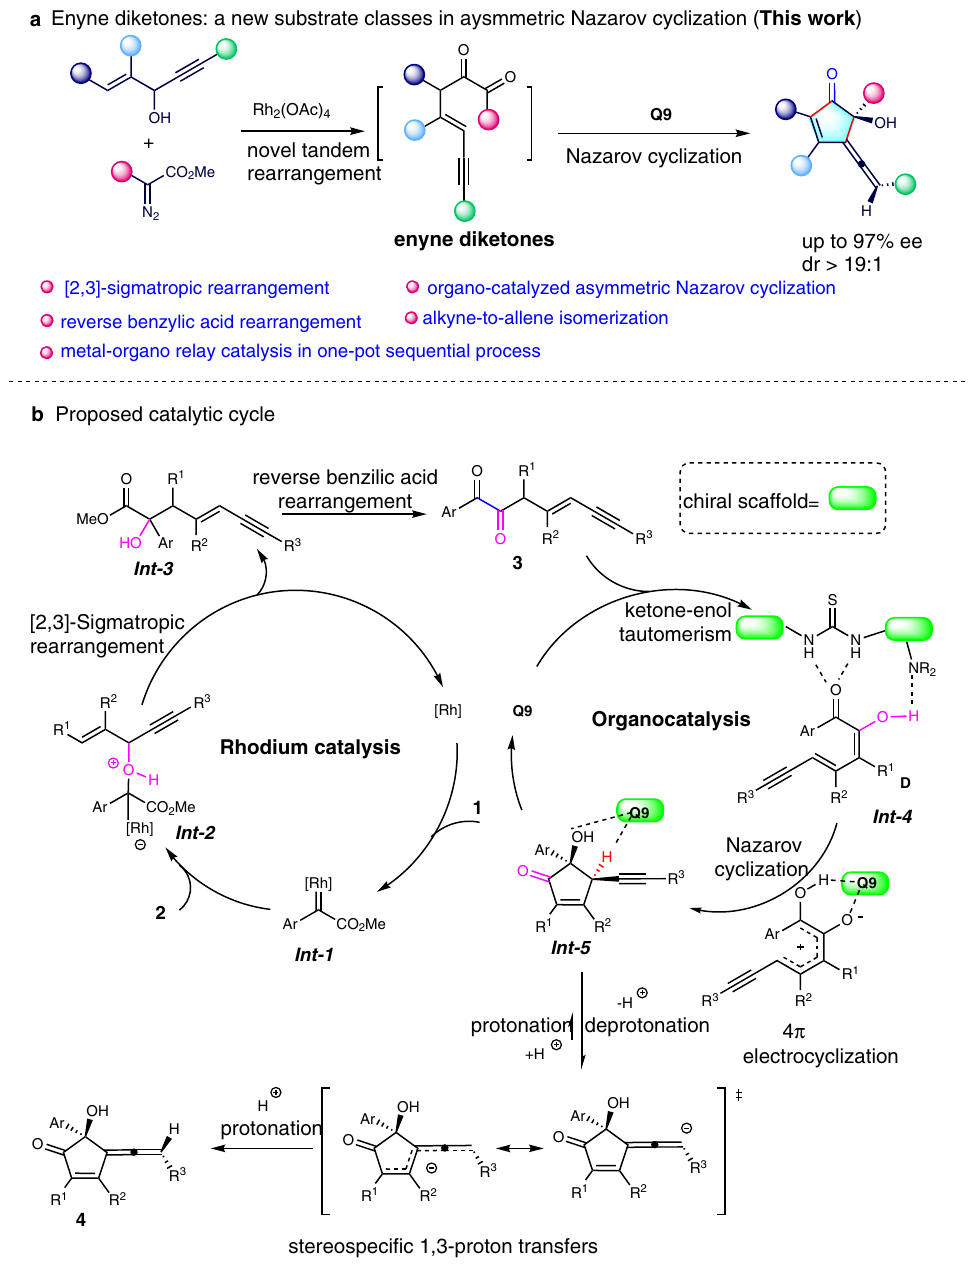
Fig. 2 Our discovery and proposed mechanism. a This work: enyne diketones: a design substrate in aysmmetric Nazarov cyclization. b Proposed catalytic cycle of our